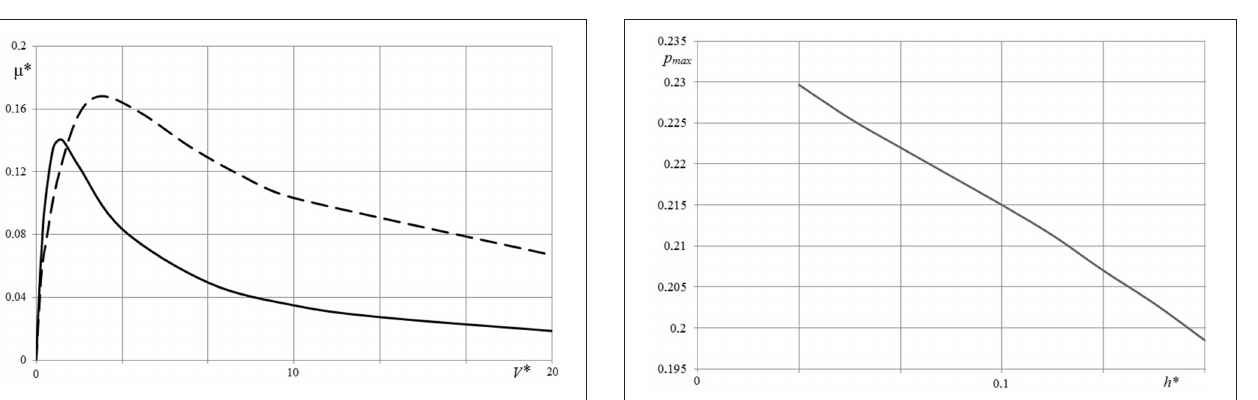
+ y 2 Here ( x 2 ) 1 / 2 is a distance between square elements, ij ij 1 ′ ( γ , ϕ , λ ) = 1 ( γ , ϕ , λ ) / q . For the first step of the